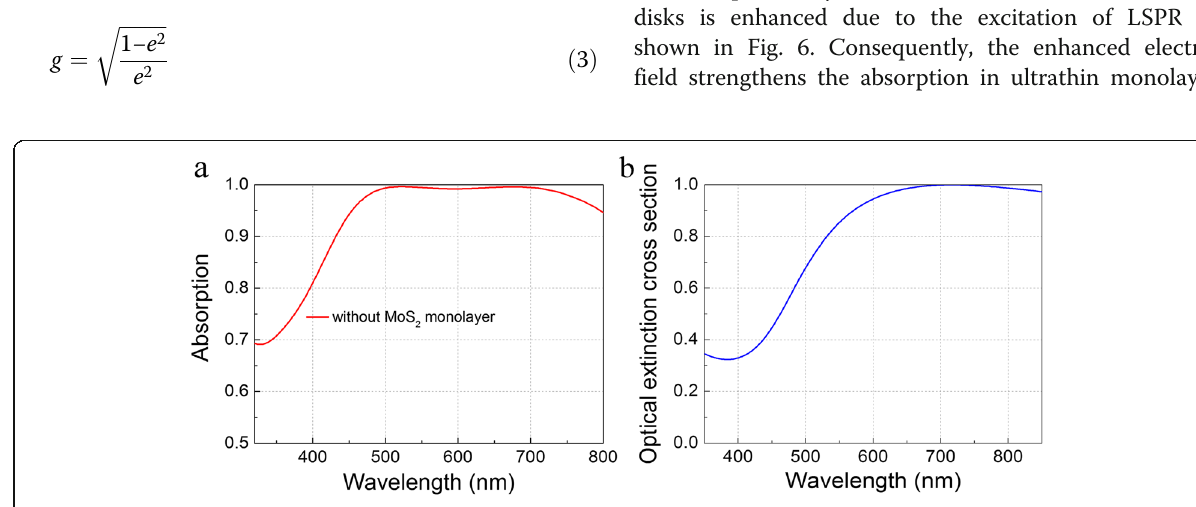
Fig. 4 a Absorption spectra without monolayer MoS 2 for p x = 200 nm, d = 120 nm, and t 1 = t 2 = 50 nm. b Normalized optical extinction cross section of TiN nano-disk illuminated with plane wave at normal